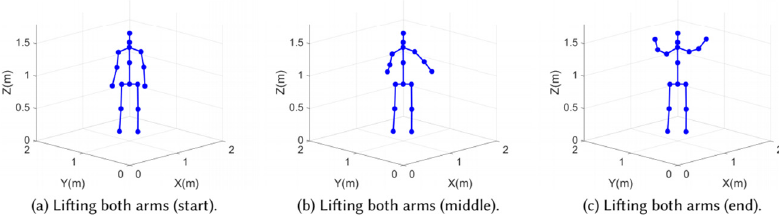
Figure 15. ( a – c ) show the continuous 3D skeleton: the process of lifting both arms.